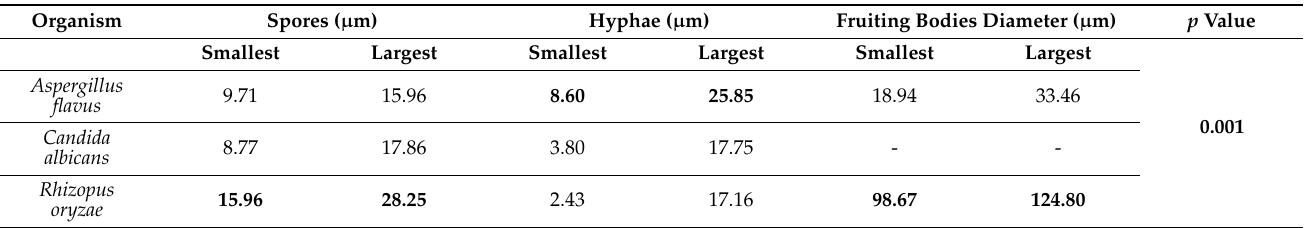
Table 8. Morphometric analysis of mean size of the spores/hyphae/fruiting body of 50 microscopic